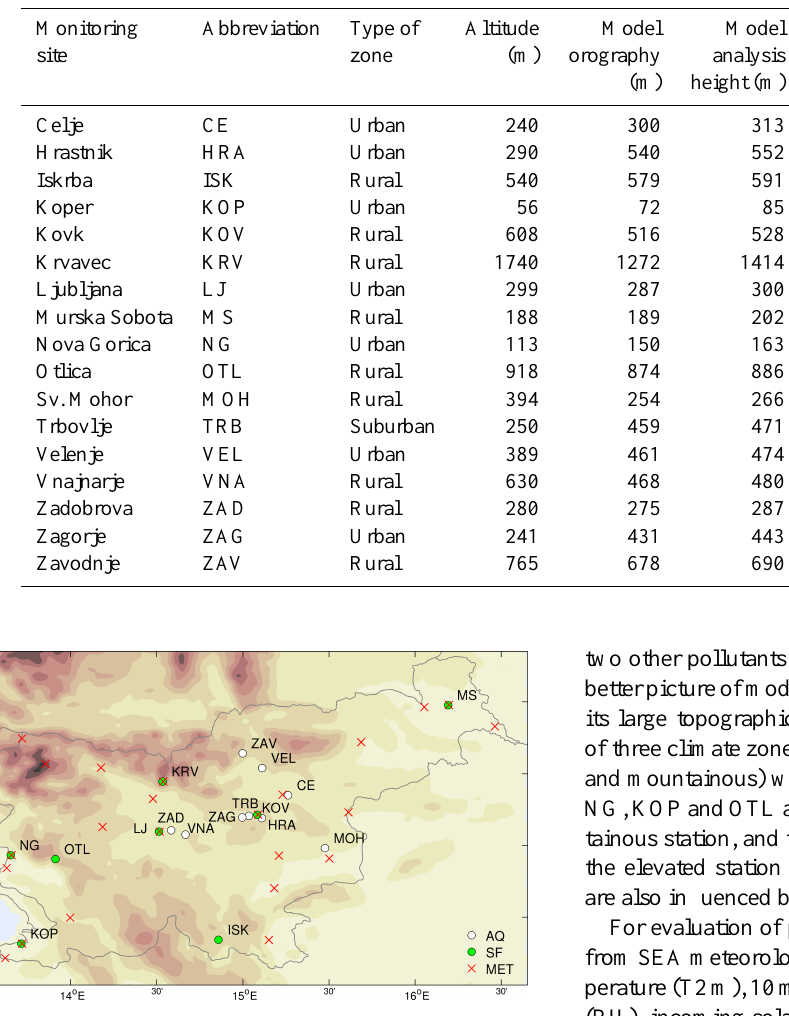
Figure 3. Locations of monitoring stations used in evaluation of air quality variables (AQ stations) and meteorological variables (MET stations). Green dots indicate measuring sites with available ozone daily maximum statistical forecast (SF). For the meaning of the AQ site abbreviations see Table